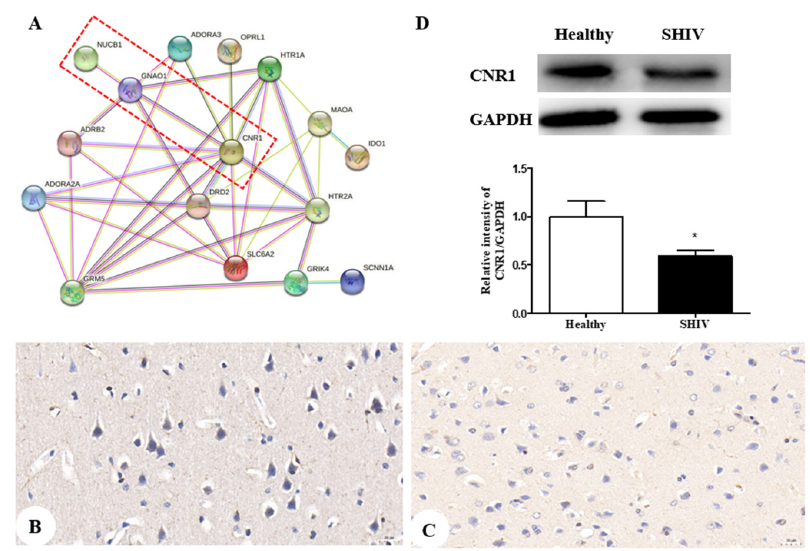
Figure 4. CNR1 protein expression in both an SHIV KU-1 -infected monkey and healthy control: ( A ) the protein-protein interactome networks; blue rectangle nodes represent down-regulated proteins; red circular nodes stand for the up-regulated proteins; the lines represent the regulation of relation- ship between two nodes; ( B ) IHC staining against CNR1 of the healthy control (400×); ( C ) IHC stain- ing against CNR1 of the SHIV KU-1 -infected monkey (400×); ( D ) comparison of CNR1 expression of cerebral cortex in healthy control and the SHIV KU-1 -infected monkey using Western blotting. In the column, from the t test, statistically significant differences of two groups can be determined ( p = 0.0366). * p < 0.05. 4. Discussion Many studies have reported significantly higher prevalence of depression in HIV- infected patients when compared to the general population [31,32]. In the present study, the prevalence of depression among HIV-infected patients was 27.33% (41/150). Moreo- ver, univariable logistic regression analysis indicated that age and marital status were as- sociated with depression ( p < 0.05). Unfortunately, the current diagnoses of depression are still based on clinical manifestations and self-rating scales as the main diagnostic criteria, as a lack of relevant objective laboratory indicators exists. Thus, there is an urgent need to search for and identify new clinical biomarkers of depression. Increased functional connectivity between the temporal lobe dysfunction and the DMN (default mode network) has been shown in depressive disorder [33,34]. Evidence from recent studies provides a deeper understanding of human learning neural networks, particularly on human PFC crucial role, proposing a theoretical model to conceptualize these psychophysiological processes. The neurovisceral integration model of fear (NVI-f) that can be impaired in the context of a psychiatric disorder [35,36] might also contribute to the advancement of alternative, more precise and individualized treatments for psychi- atric disorders. Moreover, recent studies demonstrated regulatory and functional aspects